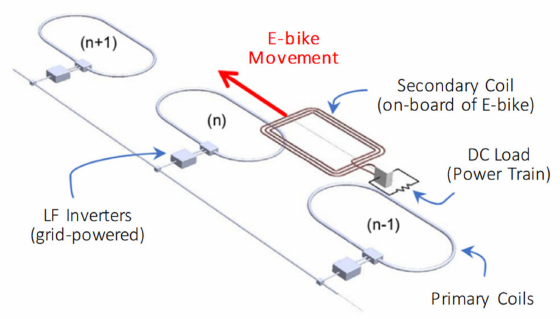
Figure 2. Configuration of the DIWPT lane system with consecutive primary